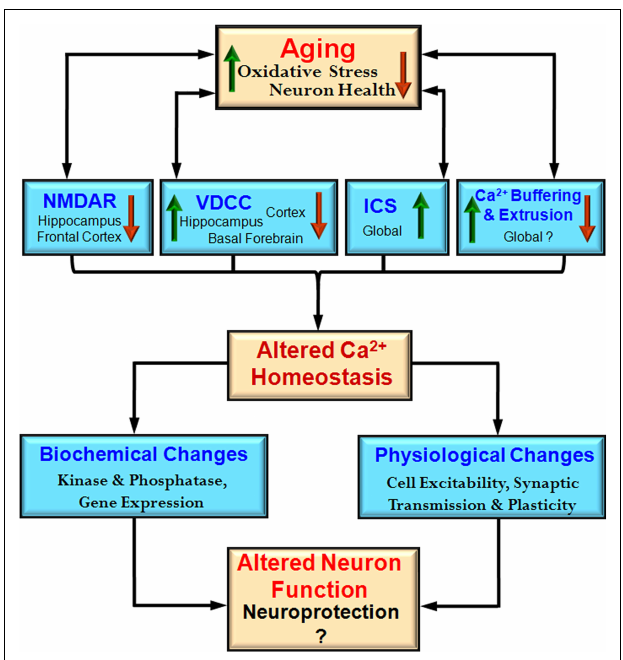
FIGURE 2 | Integrative model of the impact of aging on the Ca 2 + handling mechanisms and physiological processes. During aging there is an interaction between increased oxidative stress and decreased neuron health with mechanisms for Ca 2 + regulation including NMDA receptors ( NMDAR ), voltage-dependent Ca 2 + channels ( VDCC ), intracellular calcium stores ( ICS ), and Ca 2 + buffering and extrusion mechanisms. These changes are region and cell specifi c rather than representing a global change. An indication of regional specifi city (hippocampus, frontal cortex, cortex, basal forebrain) and the direction of change (increase – red arrow and decrease – green arrow ) for each mechanism are also provided. The shift in Ca 2 + homeostatic mechanisms may represent neuroprotective mechanisms to decrease further rise in intracellular Ca 2 + by decreasing neuron activity. These changes also impair the function of the